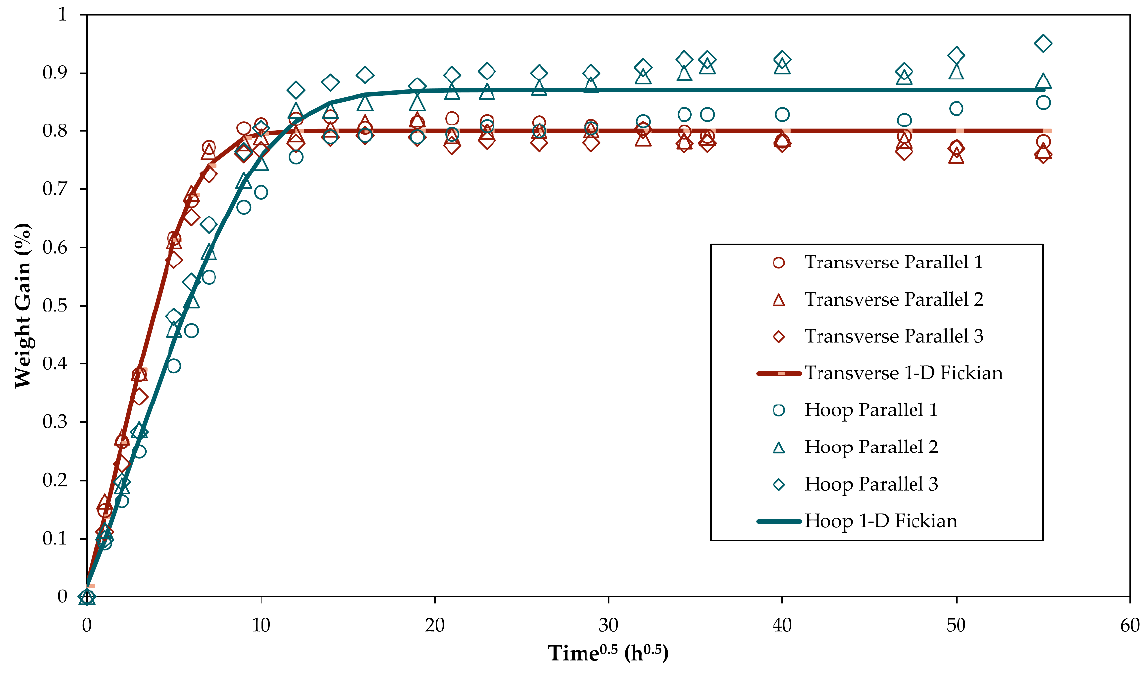
Figure 7. R-glass FRP plate with a ( bottom ; ×350 magnification) transverse and ( top ; ×350 magnification) hoop fiber orientation after a week of exposure to pH 10.0 aqueous solution.